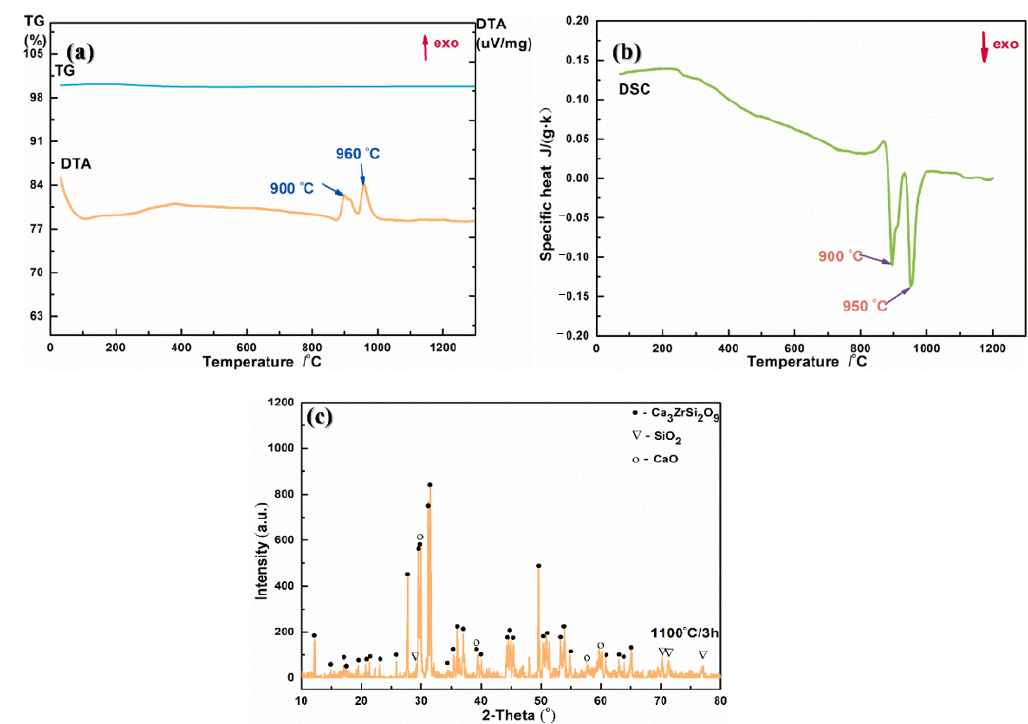
Figure 5. TG-DTA curves ( a ), DSC curve ( b ) of the as-sprayed and XRD pattern ( c ) of 1100 °C/3 h aged for CZSO coating.